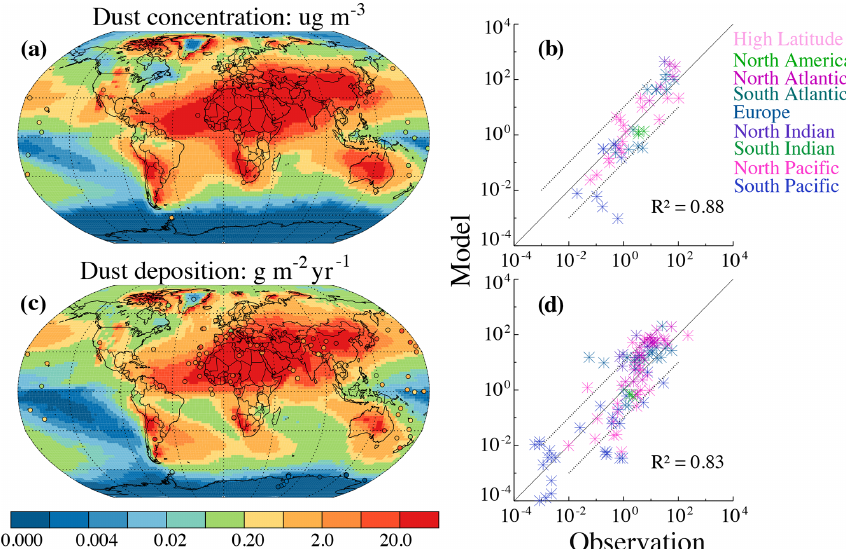
Figure 3. Comparison of simulated (the baseline case; see text for details) dust surface concentration and deposition with observations. Also shown is the correlation in the log space ( R 2 ; both significant at the 95% confidence level) between modeling and observations over sub-domains as indicated by texts in color. The dash lines in (b) and (d) represent 10:1 (upper left) and 1:10 (bottom right) lines.